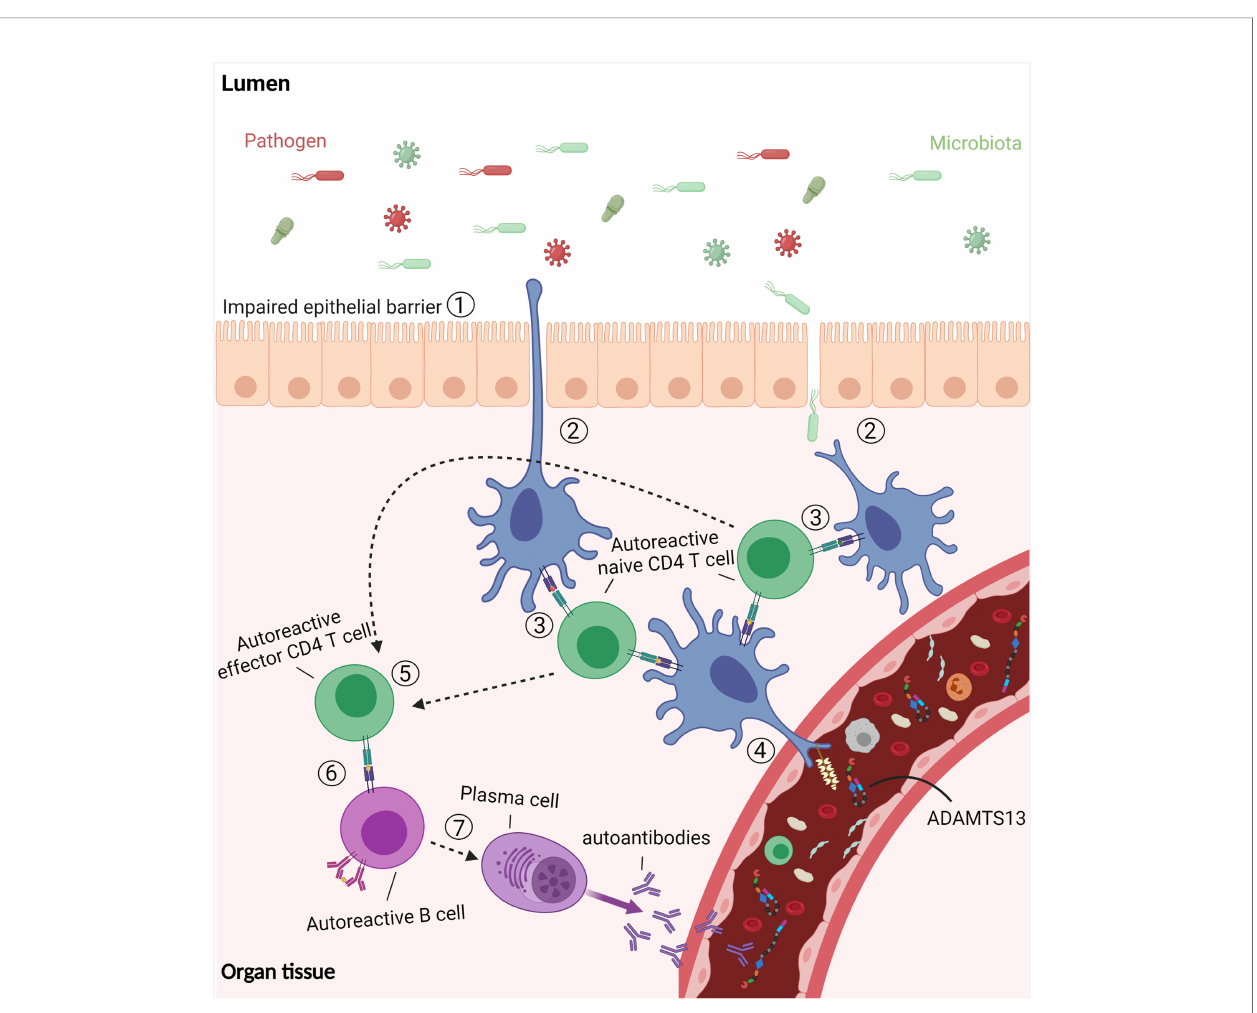
FIGURE 5 | The “ breach ” of tolerance in immune TTP. Infections disrupt the epithelial cell layer which results in the exposure of the immune system to microbiota as well as pathogens. The dendritic cells (DC) acquire antigens from the microorganisms by phagocytosis. Following processing, the DC activate cross-reactive naïve CD4 T cells which also recognize antigens derived from ADAMTS13. The activated CD4 T cells differentiate into effector CD4 T cells which interact with autoreactive B cells to induce differentiation of the B cells into autoantibodies-producing plasma cells. Figure created with